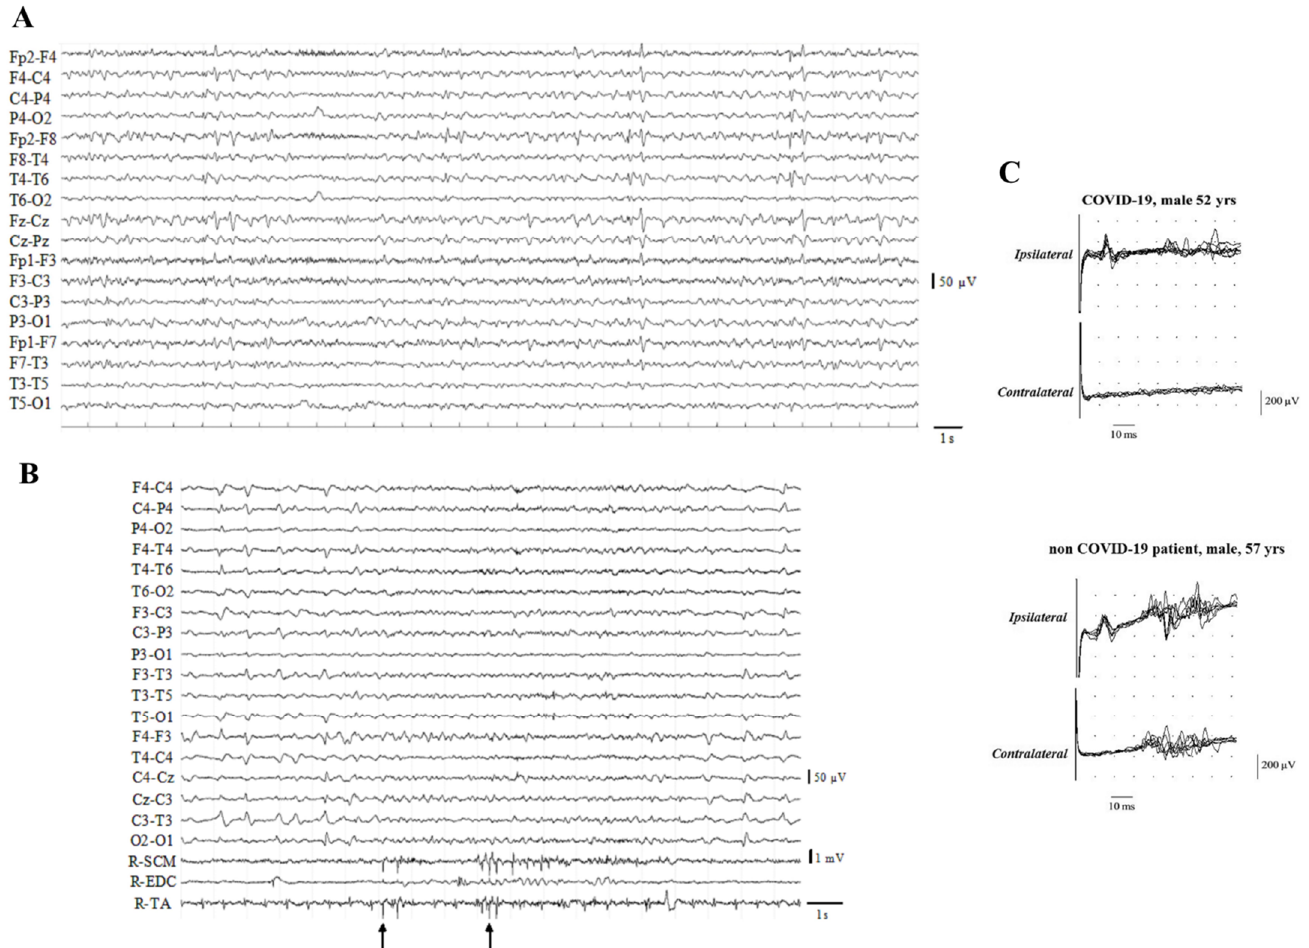
Figure 3. Neurophysiological findings in our series of COVID-19 patients with myoclonus. ( A ): Generalized periodic discharges, with a right hemisphere predominance, mainly recorded at the parasagittal and midline regions (unpublished data). ( B ): black arrows indicate waxing and waning myoclonic jerks. Note that these movements do not temporally correlate with periodic lateralized discharges at EEG, without a prominent proximal-to-distal gradient of appearance; all these features suggest a sub-cortical origin of the myoclonus (surface poly-EMG recorded from the right sternocleidomastoid , extensor carpi radialis longus , and tibialis anterior muscles; unpublished data). ( C ): Blink Reflex (eight superimposed traces) recorded in a COVID-19 patient (top) and a non-COVID-19 patient (bottom). In the former, ipsilateral RII responses had markedly prolonged latencies and contralateral RII were absent, suggesting a pontomedullary lesion (modified with permission from [40]).